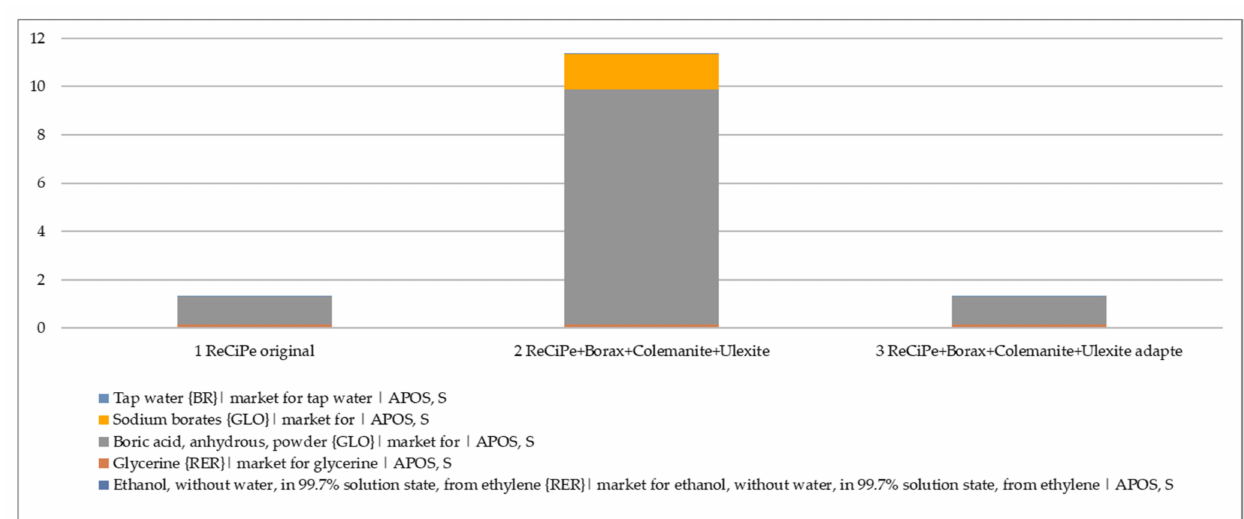
Figure 5. Results with CML 2002 expressed in kg antimony equivalents.